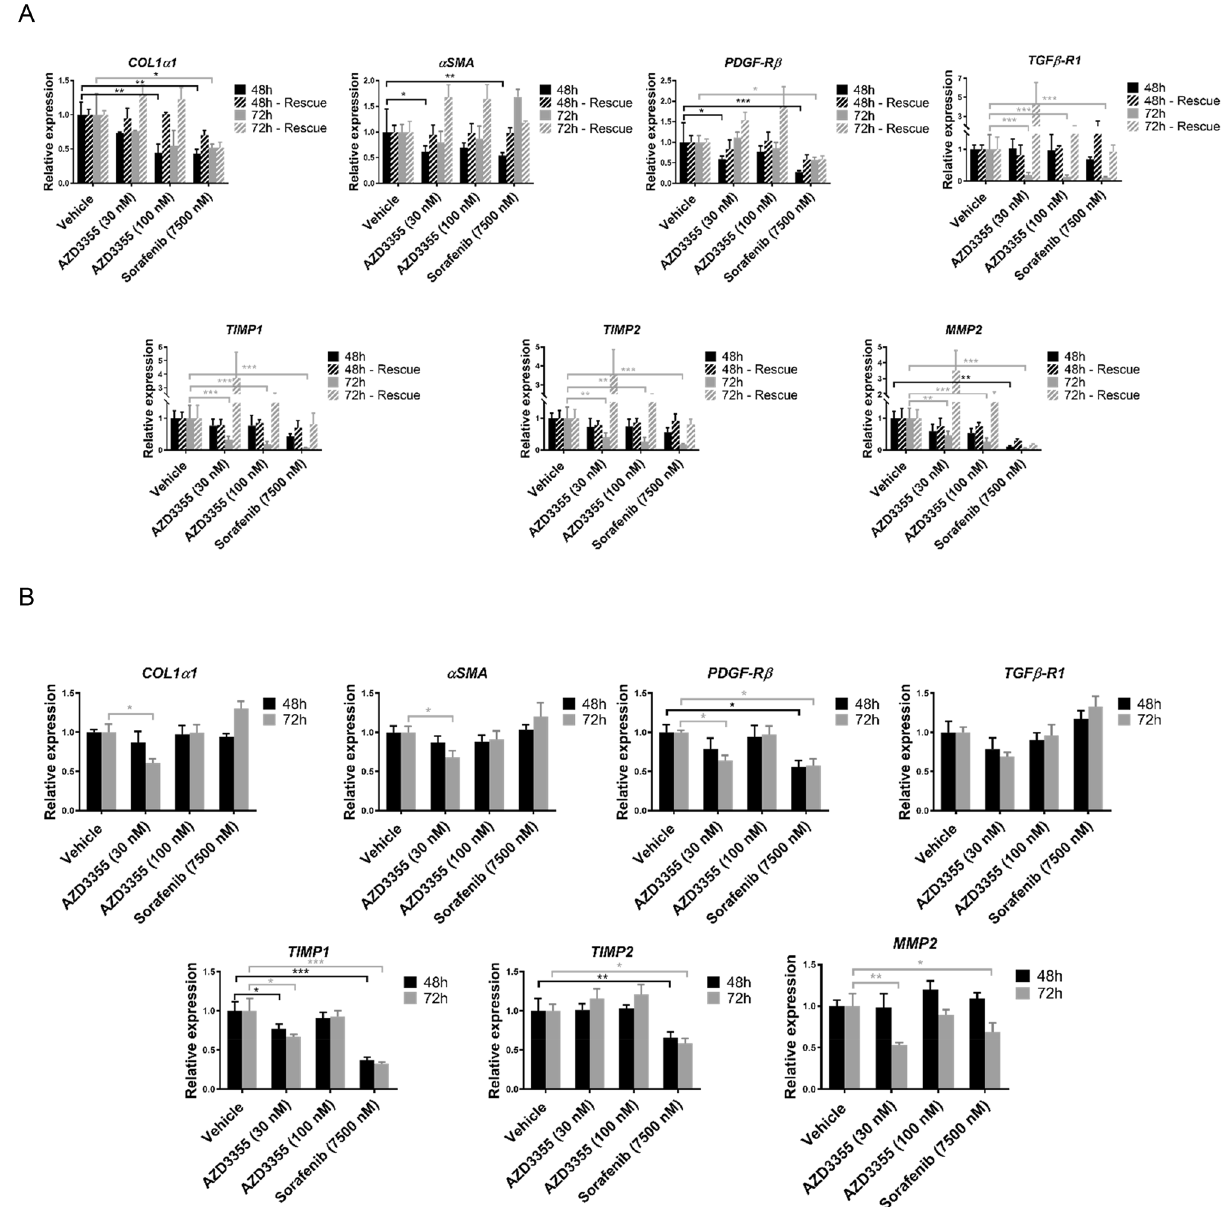
Figure 2. AZD3355 down-regulates activation-related mRNAs in HSCs. LX-2 cells ( A ) were treated with either DMSO (as vehicle) or either AZD3355 (30 nM or 100 nM) and 7500 nM Sorafenib (as positive control) for 48 and 72 h. The vehicle or drugs were withdrawn after 48 and 72 h and cells were maintained in DMEM media with 10% FBS for an additional 48 and 72 h, respectively. Dose-dependent down-regulation of fibrogenic related mRNA expression was observed in response to AZD3355 treatment. Recovery of gene expression in (striped bars) after drug removal (solid bars) indicates that down-regulation was reversible and not due to toxicity. Primary human hepatic stellate cells ( B ) were treated as described for as LX-2 cells (without rescue). Stellate cell activation genes were significantly down-regulated in 30 nM AZD3355 at 72 h treatment. Results are reported as means ± SEM (n = 3). * p < 0.05, ** p < 0.01, *** p <